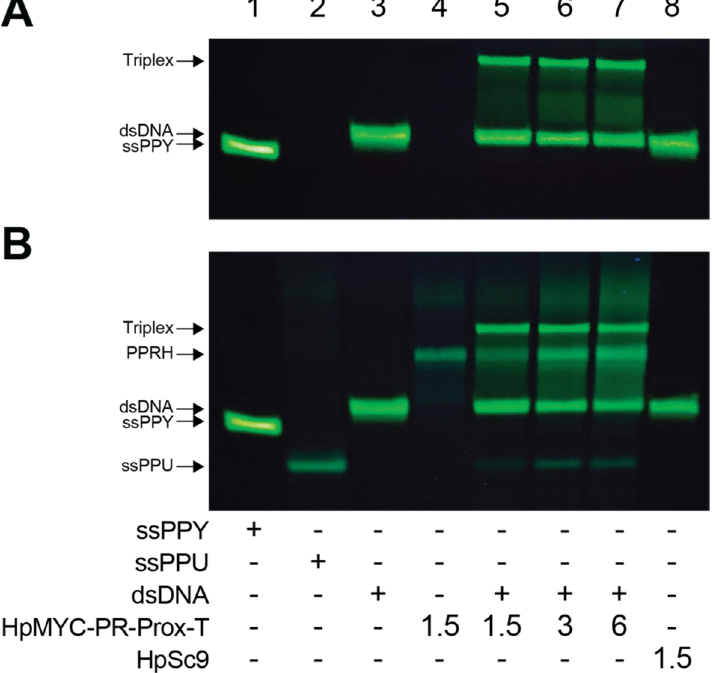
Figure 4. Displacement analysis of the Polypurine (ssPPU) strand in the proximal promoter probe. ( A ) Bindings were performed using 1.5 µg of dsDNA labeled with FAM (green) in the single-stranded (ss) PPY strand only, then incubated with the indicated amounts of HpMYC-Pr-Prox-T or 1.5 µg of HpSc9. The resulting structures were resolved by native polyacrylamide (12%) gel electrophoresis and visualized with UV light (green bands). ( B ) Visualization of PPRHs, ssPPU, and displaced PPU bands after Thioflavin-T staining (cyan bands). The image is representative of at least 3 different strand displacement